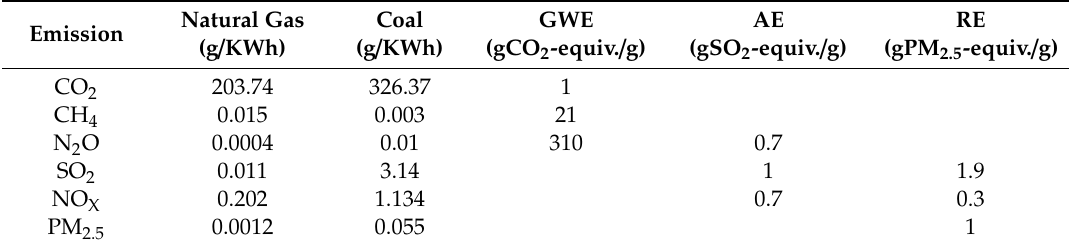
Table 2. Emission conversion factors and global warming e ff ect (GWE), acidification e ff ect (AE) and emission e ff ect (RE) of some